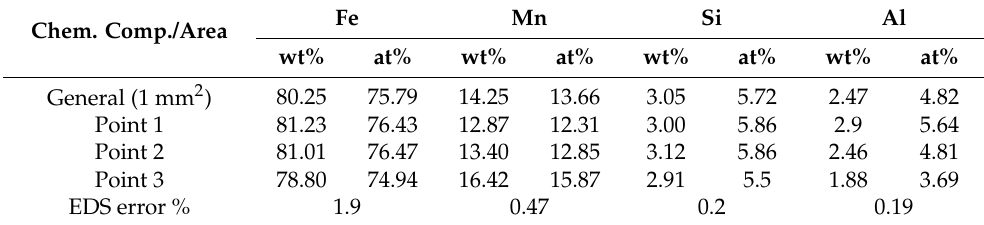
Table 1. The chemical composition determinations (five times average values).